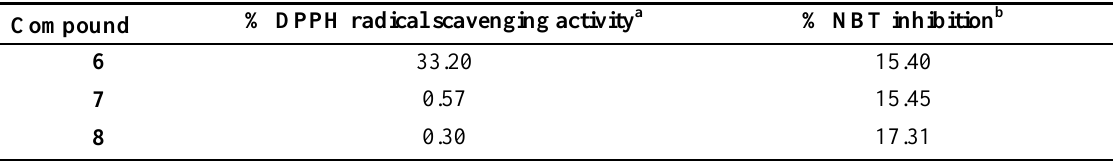
Table 4. Antioxidative activities of analogs 6 - 8